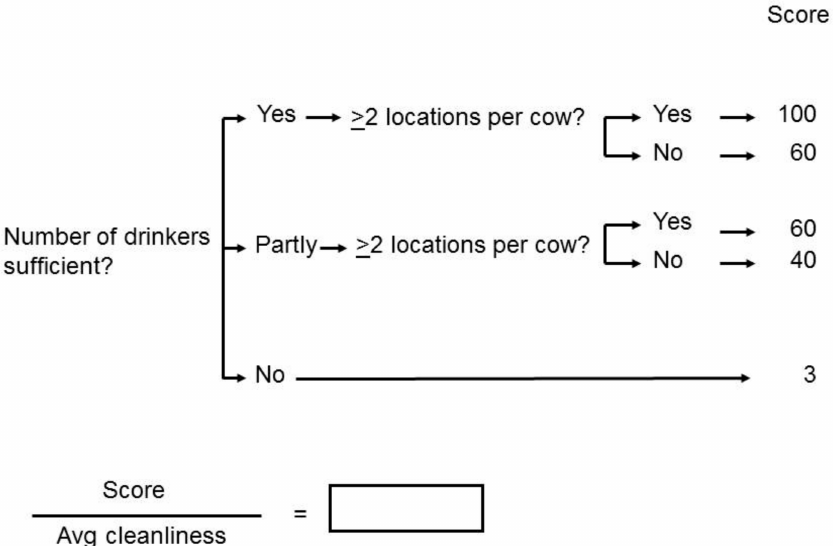
Figure 1. The scoring for water in the new Welfare Monitor for dairy cattle. For the determination of the number of drinkers being sufficient, the requirements of the Welfare Quality ® assessment protocol [3] (see Supplementary Materials) were used. Then it was checked if there were at least two drinking locations available per cow [3]. The cleanliness was scored in points per drinker: clean = 1; partly dirty = 2; dirty = 3. The average of all drinkers was computed and used in the calculation: The result of the number and locations was divided by the average of the